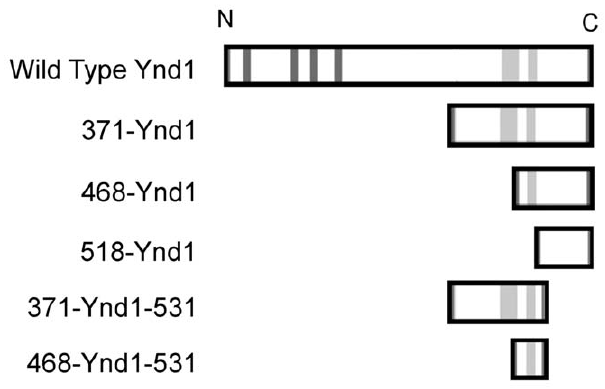
Figure 1. Ynd1 constructs. A schematic representation of WT and mutant Ynd1 proteins is shown. The dark grey lines in the WT protein represent apyrase-conserved-domains found in the N-terminal, luminal part of the protein, and the light grey lines represent hydrophobic domains. The rightmost hydrophobic domain was determined to be the transmembrane domain [26]. All Ynd1 constructs carry a Myc tag at their amino terminus (N) and a HA tag at the carboxyl terminus (C).